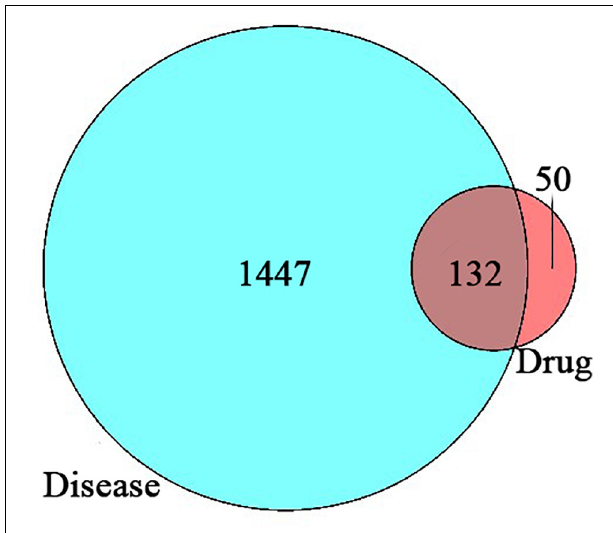
FIGURE 1 | The Venn diagram of intersection targets.